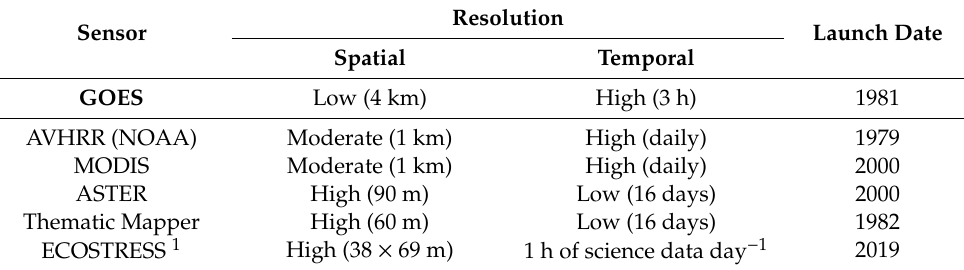
Table 2. Comparison of thermal-infrared sensors.